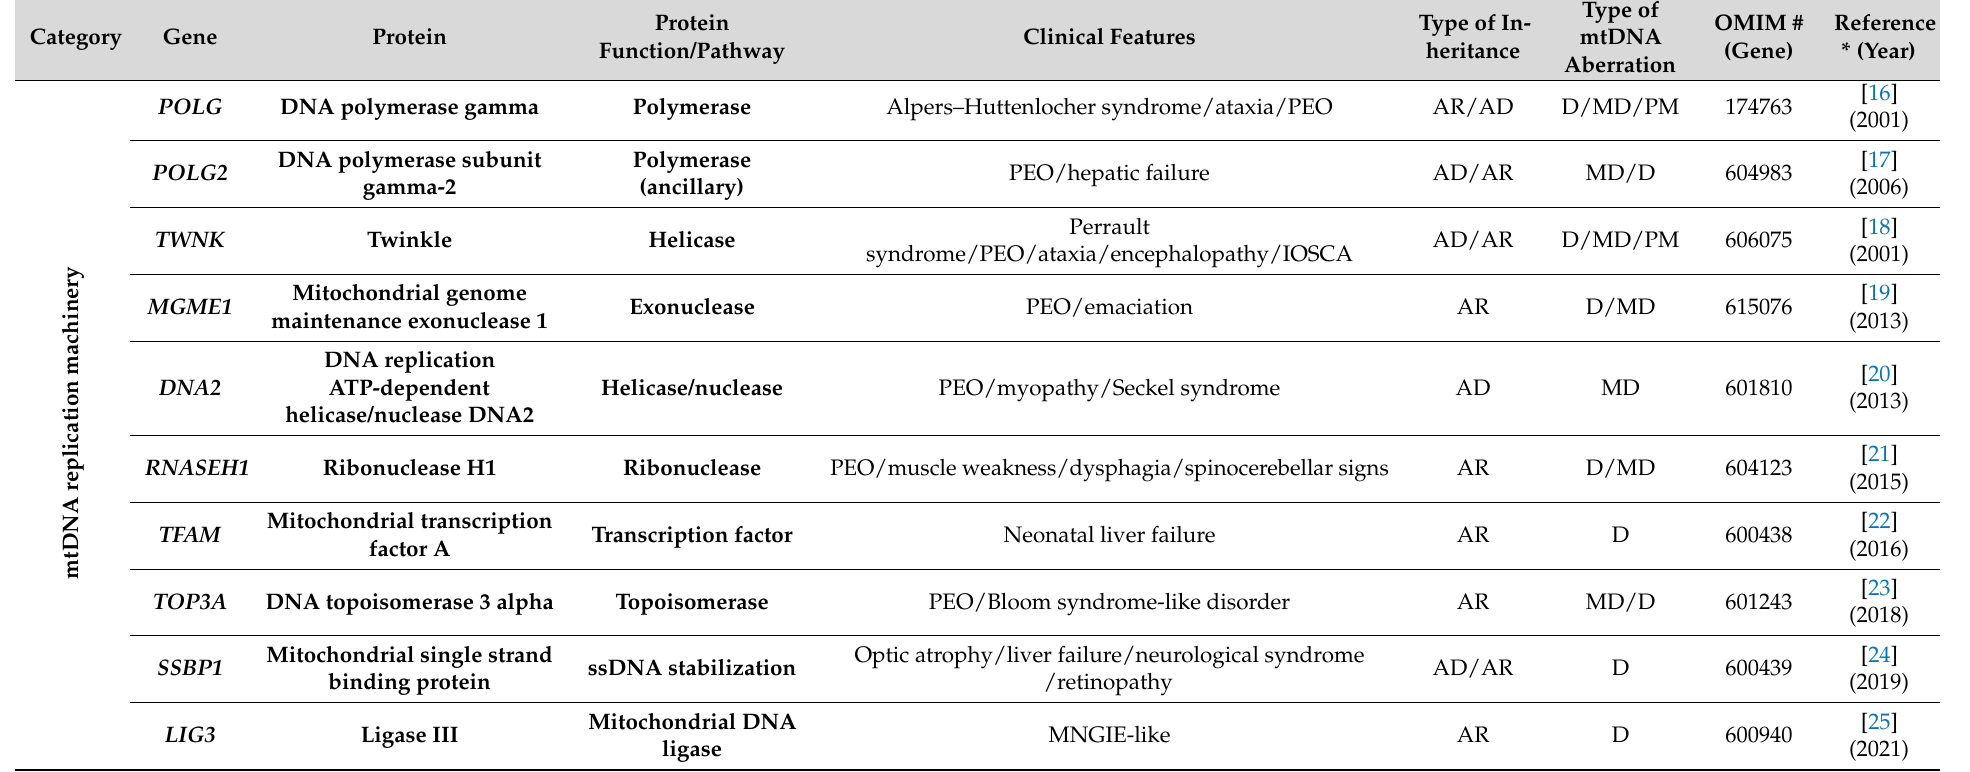
Table 1. Genes associated with mitochondrial DNA replication